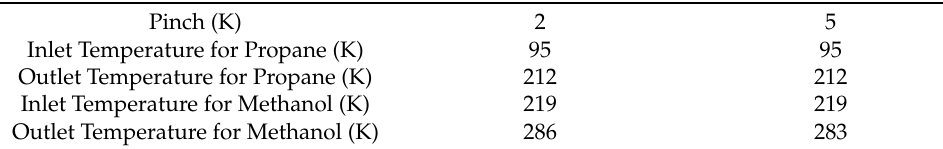
Table 5. Temperature of propane and methanol. Pinch